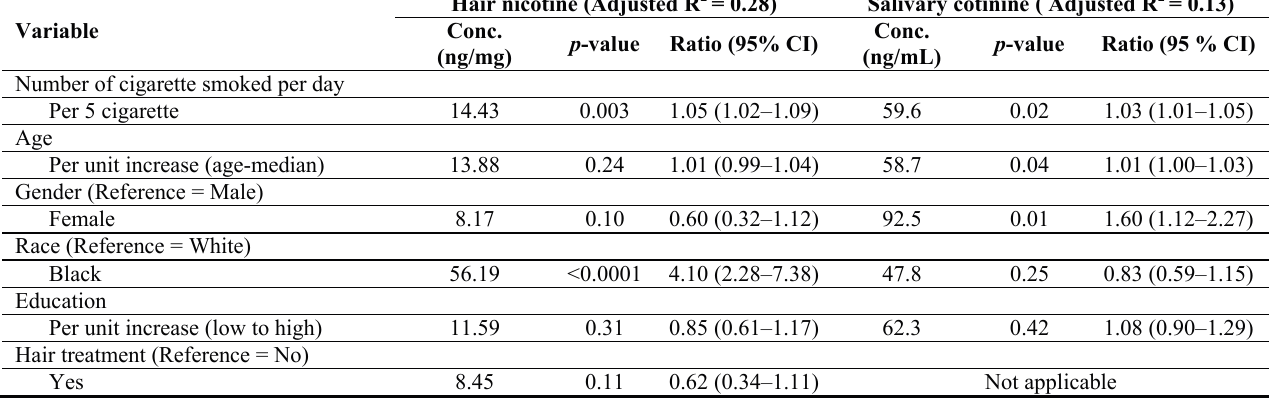
Table 2. Geometric means (GMs) and geometric mean ratios (GMRs) of hair nicotine and salivary cotinine concentrations per 5 cigarettes for self-reported smokers’ after adjustment for age, gender, race, education, and hair